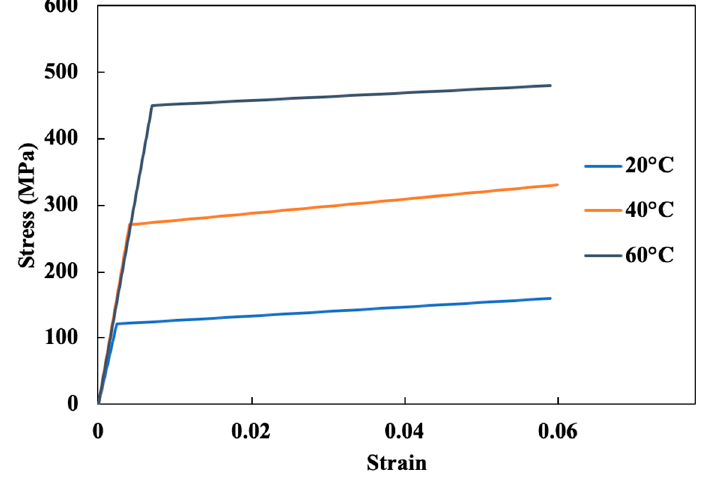
perature through 60 ° C. Figure 6 show the stress–strain response approximation from [32].